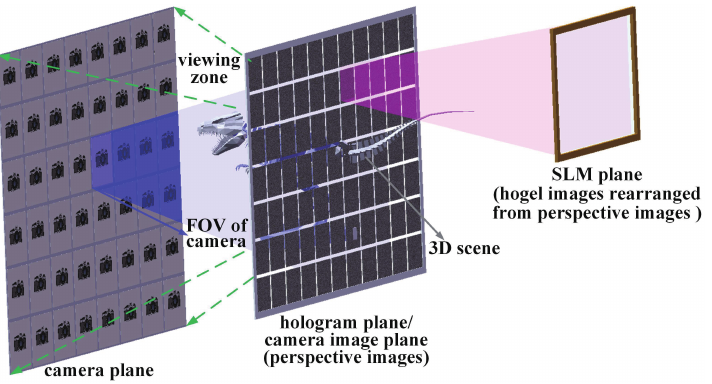
Figure 6. Hogel images are generated by a camera placed on the viewing zone of the holographic stereogram.